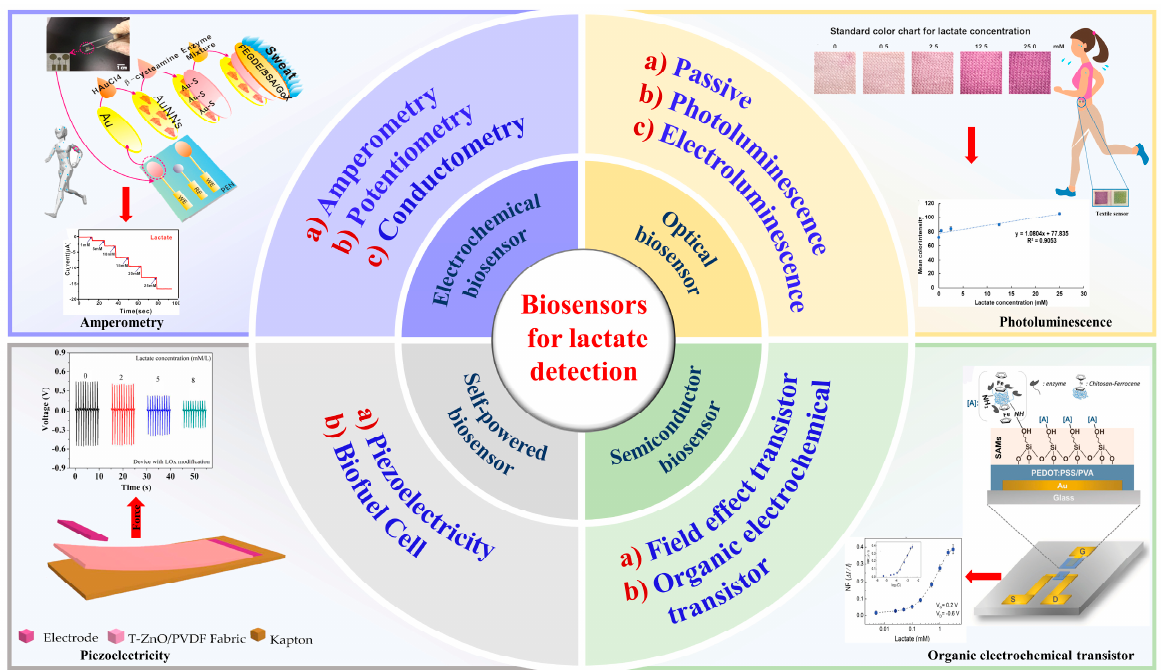
Figure 1. Biosensors for lactate detection in human biofluid. Reprinted with permission from ref. [16]. Copyright 2021 Elsevier. Reprinted with permission from ref. [17]. Copyright 2019 Elsevier. Reprinted with permission from ref. [18].